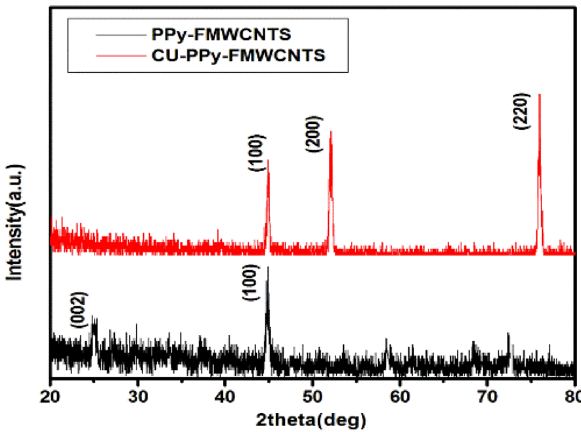
Figure 3. XRD spectra of PPy-FMWCNTs, Cu-PPy-FMWCNTs nanocomposites.